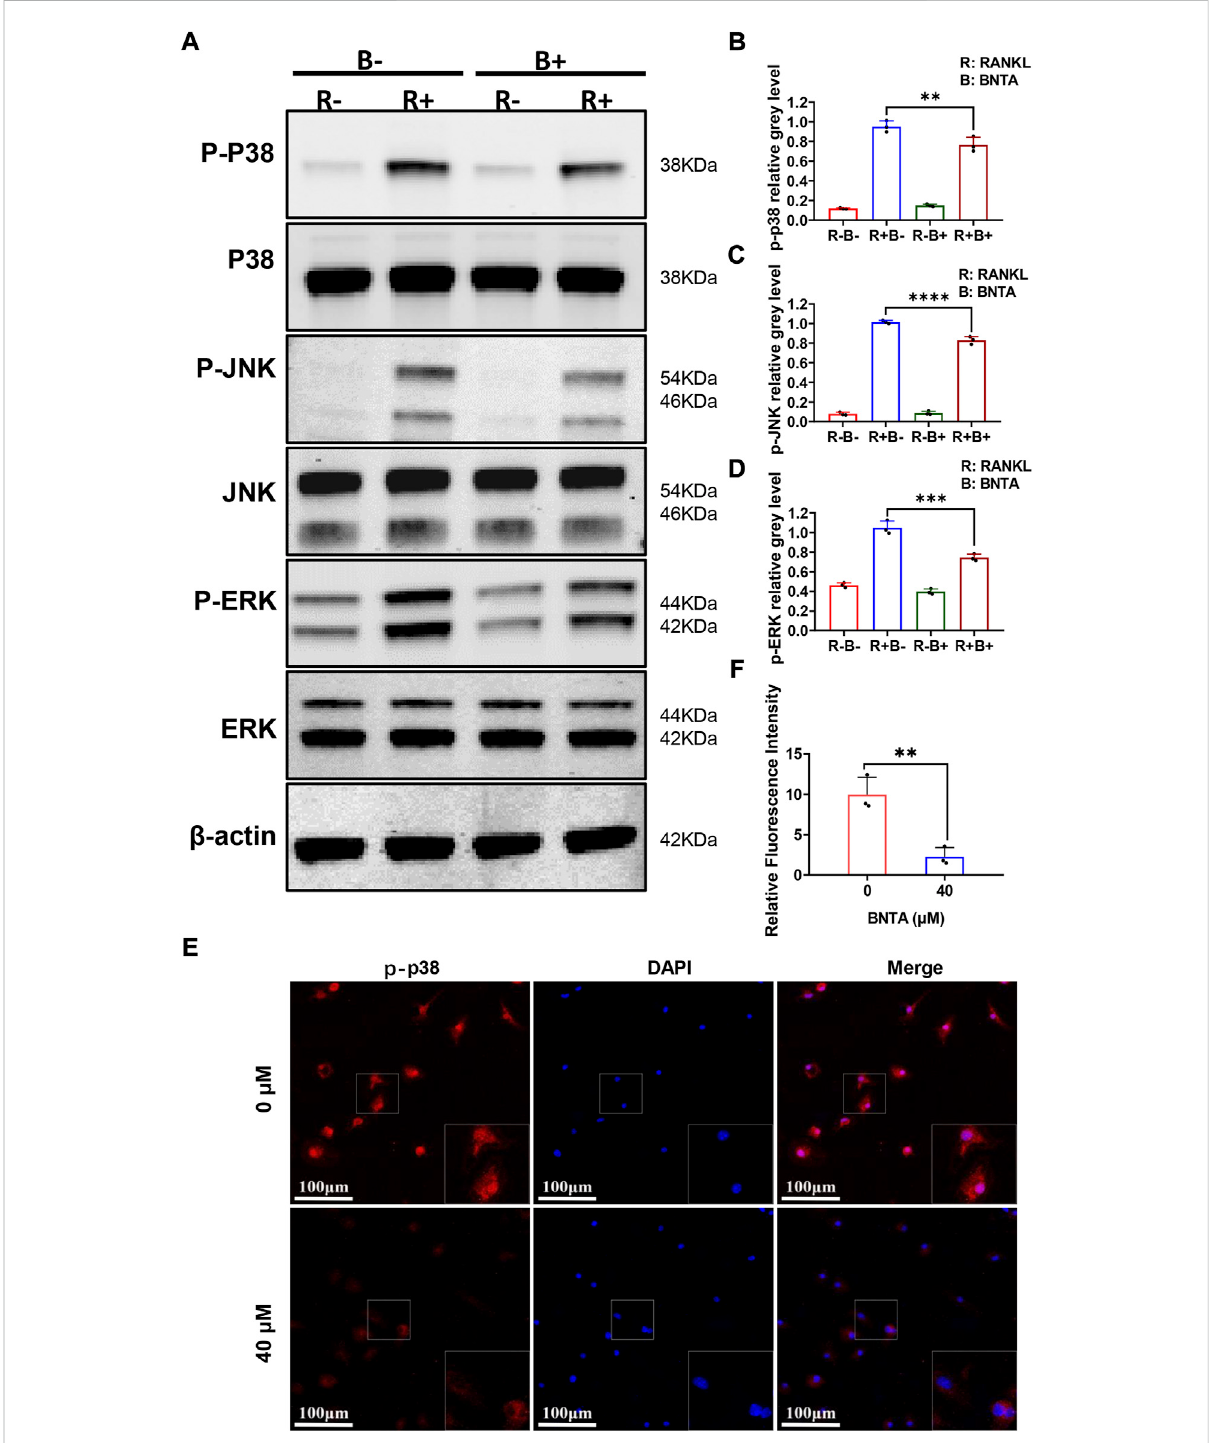
BNTA inhibited osteoclastogenesis via the MAPK signaling pathway. (A) Representative Western Blot images of BNTA on the MAPKs pathway, including p38, ERK, and JNK. (B – D) Quanti fi cation of the ratio of band intensity of p-p38/p38, p-JNK/JNK, p-ERK/ERK ( n = 3 per group). All data are presented as mean ± SD. ** p < 0.01, *** p < 0.001, **** p < 0.0001 compared with control group. (E) Representative immuno fl uorescence images of the effect of BNTA on the phosphorylation and nucleus translocation of p-p38 with stimulation of RANKL. (F) Quanti fi cation of the ratio of fl uorescence intensity ( n = 3 per group). All data are presented as mean ± SD. ** p < 0.01compared with control